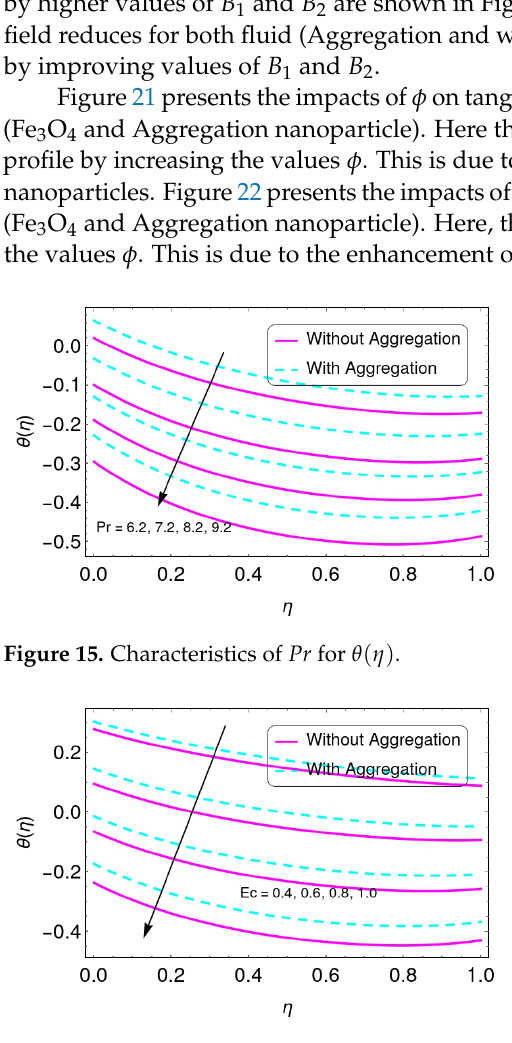
Figure 16. Characteristics of Ec for θ ( η ) .